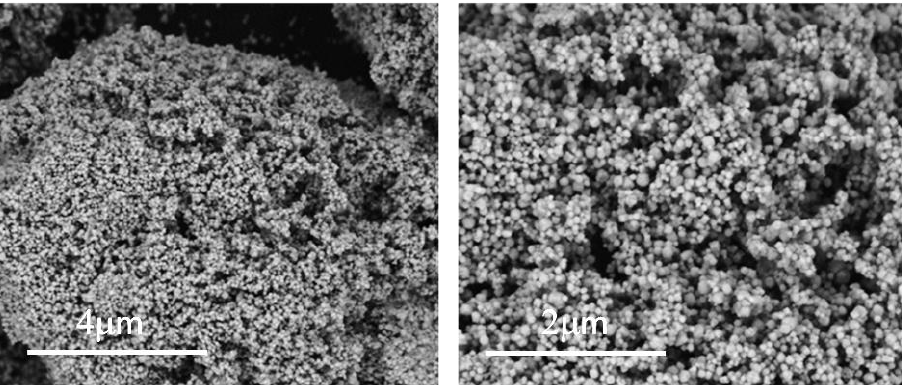
Figure 3. FE-SEM micrographs of synthesized ZHS nanoparticles at 30 k and 60 k magnification. Figure 4 shows an EDS spectrum from the particle agglomerates. The EDS spectrum